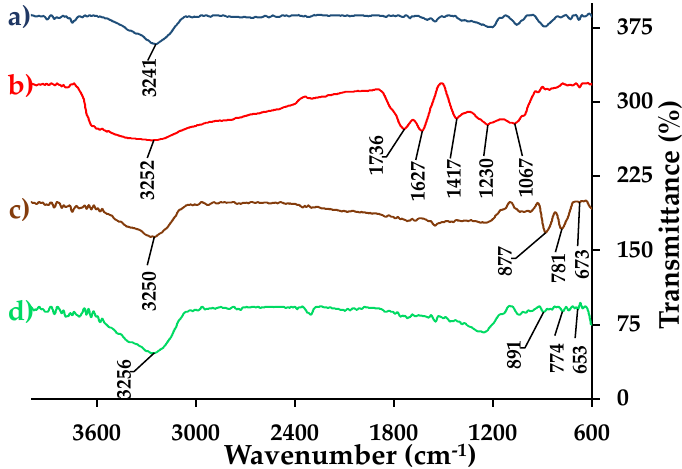
/ rGO 1, and ( d ) α -FeOOH / rGO